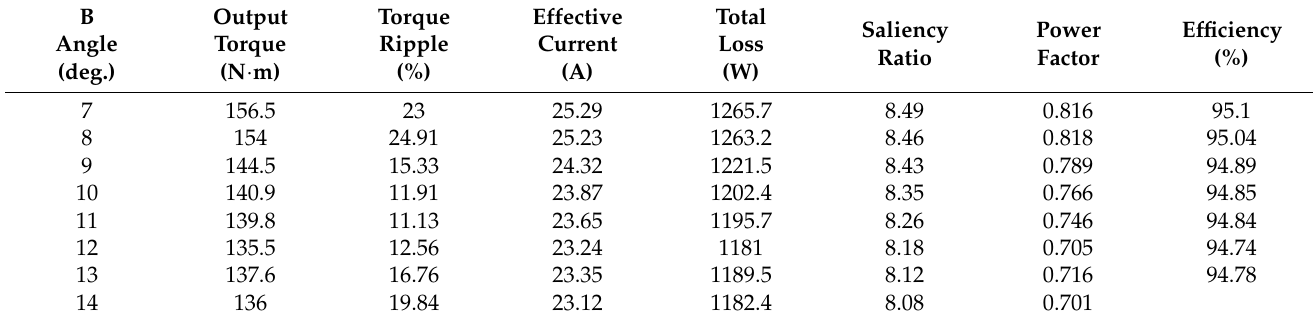
Table 4. Analyzes on control angle.